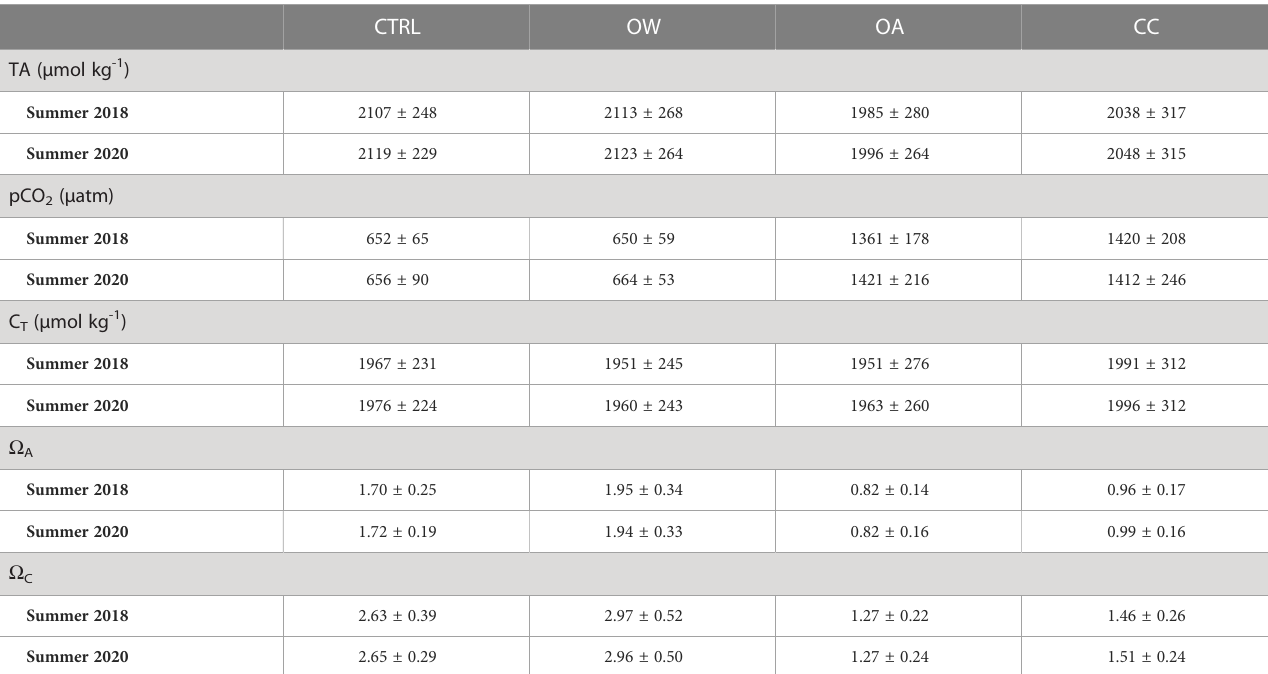
TABLE 3 Average (± SD) seawater carbonate chemistry of four experimental treatments. CTRL OW